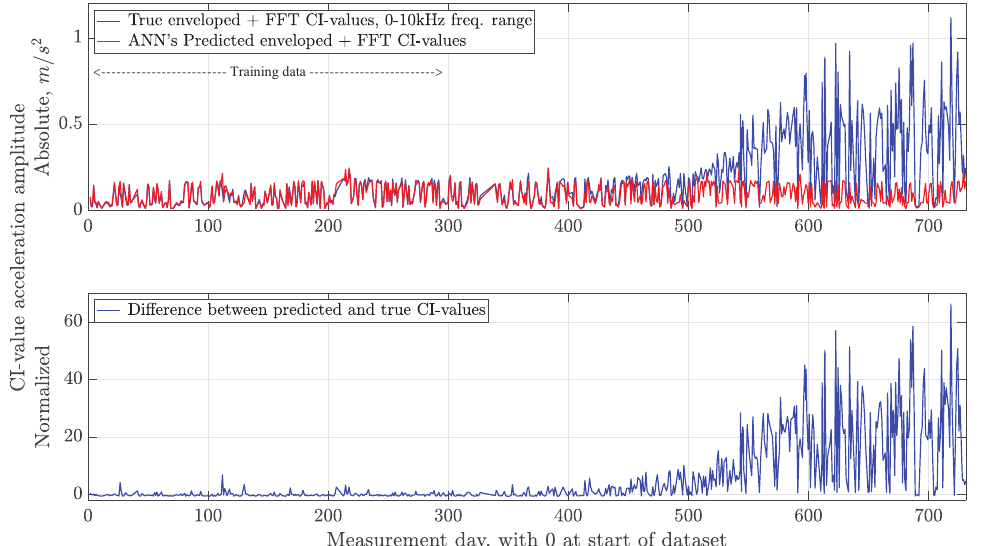
Figure 10. Gearbox output shaft bearing failure case 3, enveloped FFT CI-values from measurements with a 0–10 kHz frequency range trended per day of the dataset starting at 0. Comparison of ANN’s predicted CI-values in red and true CI-values in blue at the top graph and normalized difference between them at the bottom